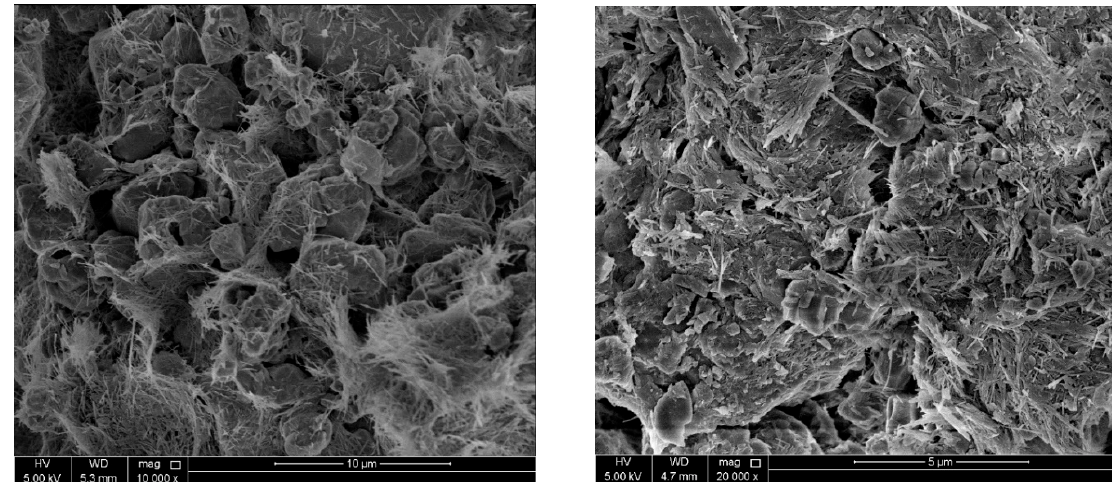
Figure 6. SEM images of TBM muck Sample #3 at different scales.